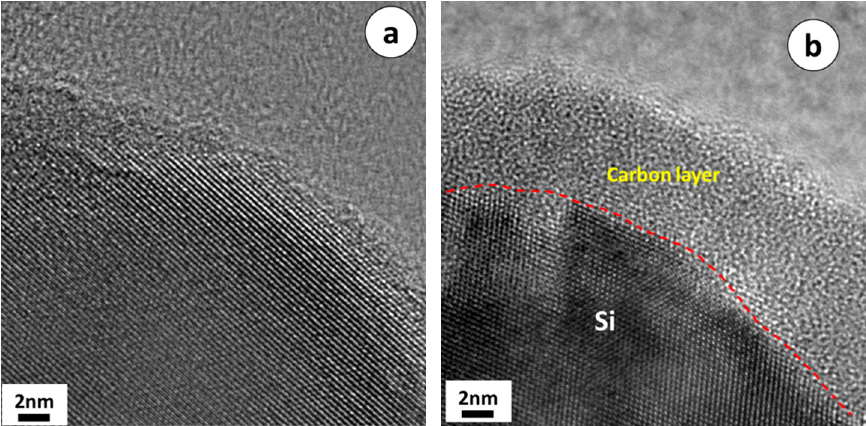
Figure 5. HRTEM images of ( a ) p -Si particles and ( b ) p -Si@C composites with carbon content of 45 wt.%.